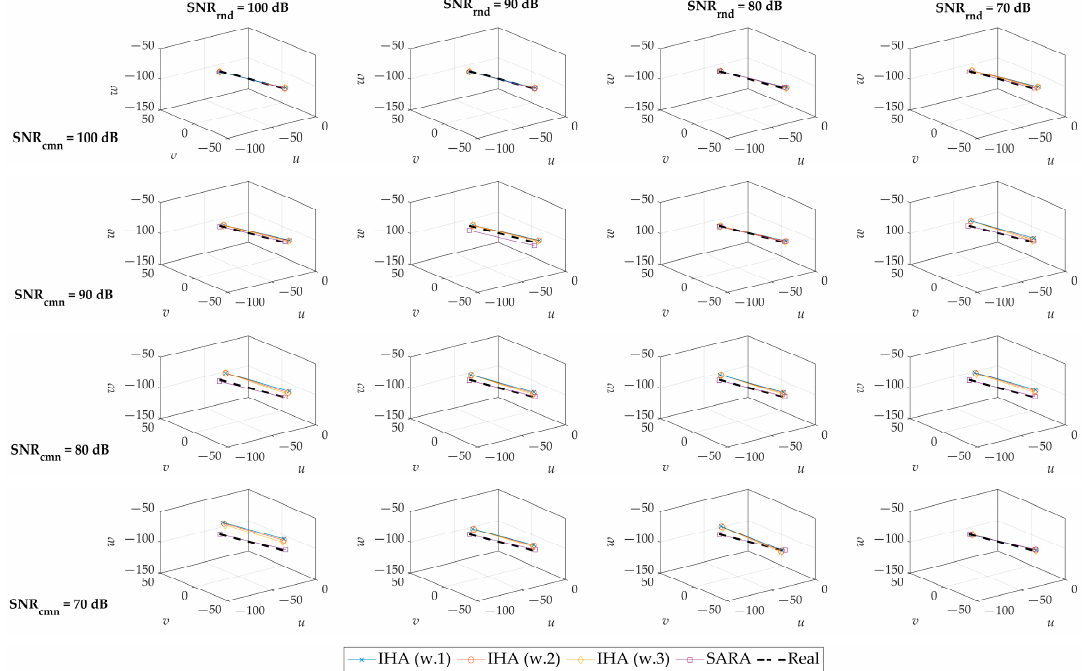
Figure 9. AoRs calculated with MHA, by choosing different weighting factors, and SARA, for motion configuration D. Each row and column correspond to a particular level of common and random noise signals, in terms of signal-to-noise ratios. The exact AoR imposed by joint kinematics setup is highlighted in dashed black line. All axes units are in mm.